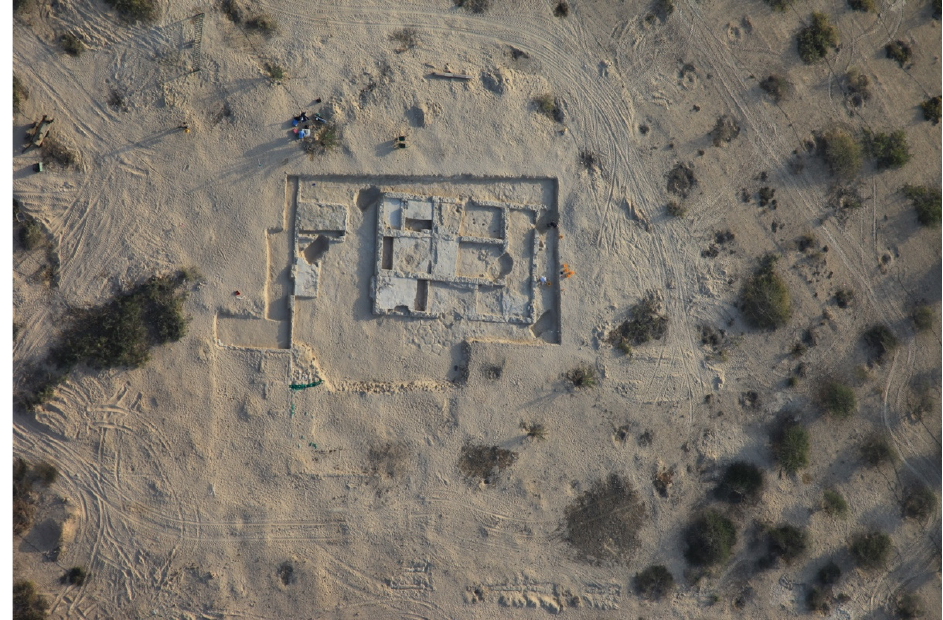
Figure 3. Aerial view of the Nestorian church, in the courtyard of the monastery at Sir Bani Yas, during excavation (2009).